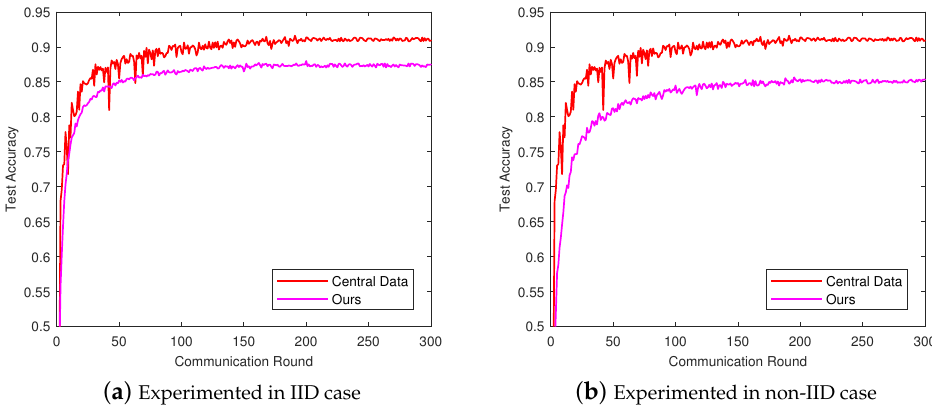
Figure 5. Accuracy comparison of FL for CIFAR10 data set in IID and non-IID